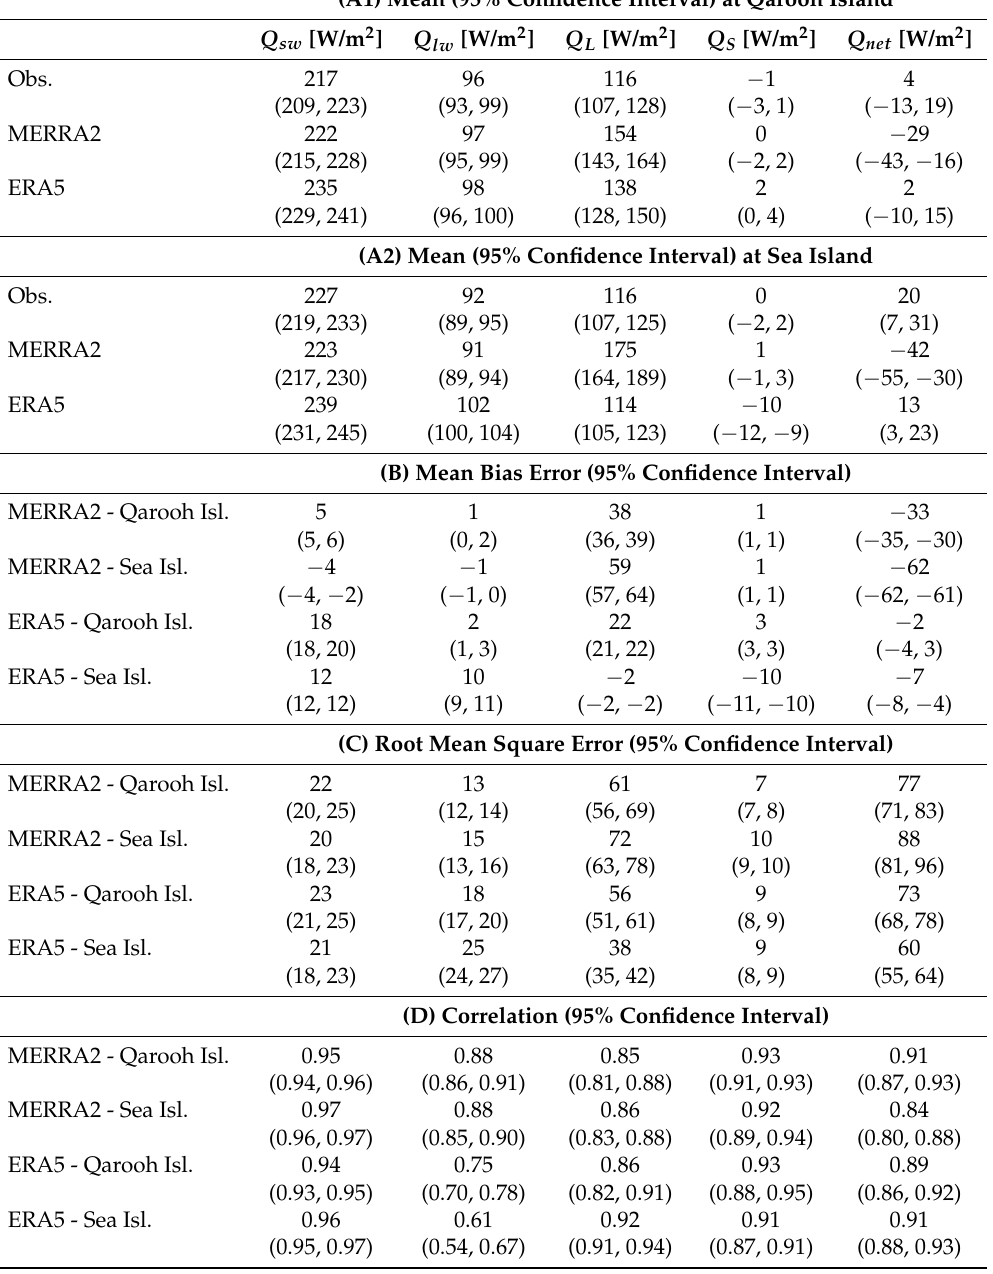
Table 5. Comparison between reanalysis products (NASA-MERRA2 and ECMWF-ERA5) and observations for shortwave radiation ( Q sw ), longwave radiation ( Q lw ), latent heat flux ( Q L ), sensible heat flux ( Q S ), and net heat flux ( Q net ), with 95% bootstrap confidence intervals given in parentheses (using 1000 bootstrap samples), for January 2013 to March 2014. (A1–A2) Mean values at the two